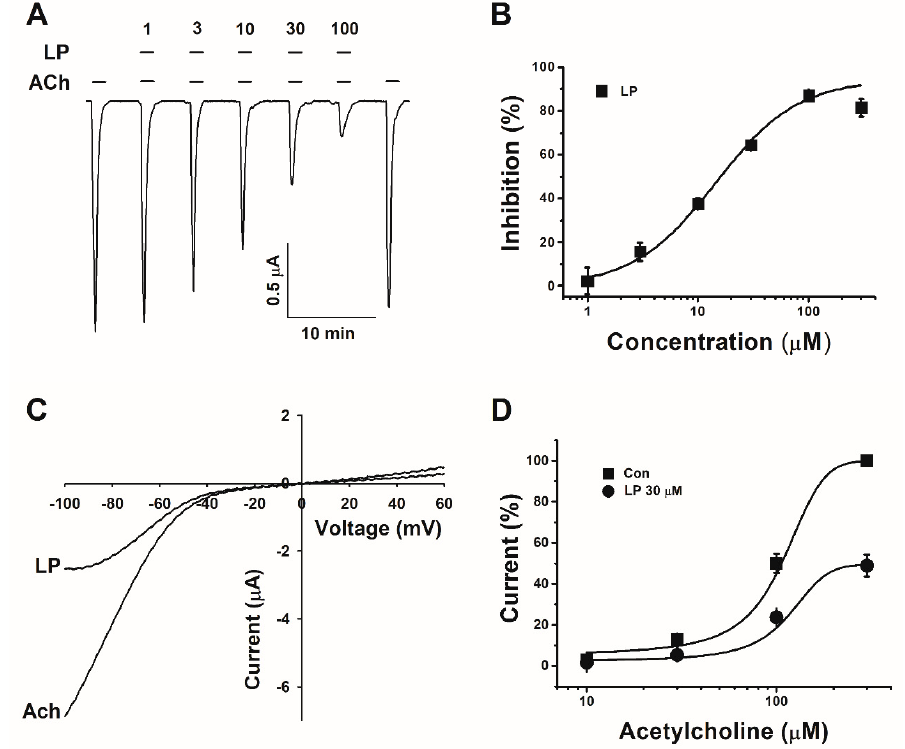
Figure 2. Mechanism by which lupeol interacts with α 3 β 4 nicotinic acetylcholine receptors. ( A ) Inward currents of trace for cotreatment of acetylcholine and lupeol in α 3 β 4 nACh receptor. ( B ) Concentration–response relationship induced by cotreatment of lupeol in α 3 β 4 nACh receptors. Each point represents mean ± SEM ( n = 10 – 13/group). ( C ) Representative current–voltage relationship obtained by using voltage ramps from − 100 to + 60 mV at holding potential of − 80 mV. Voltage steps treated with 100 μ M acetylcholine alone, and cotreated with 30 μ M lupeol with ACh ( n = 7–9 from four different frogs). ( D ) I Ach induced by various concentrations of acetylcholine ( ■ ) and cotreatment with 30 μ M lupeol ( ● ). Oocytes voltage-clamped at holding potential of − 80 mV. Each point represents mean ± SEM ( n = 10–13 from five different frogs).